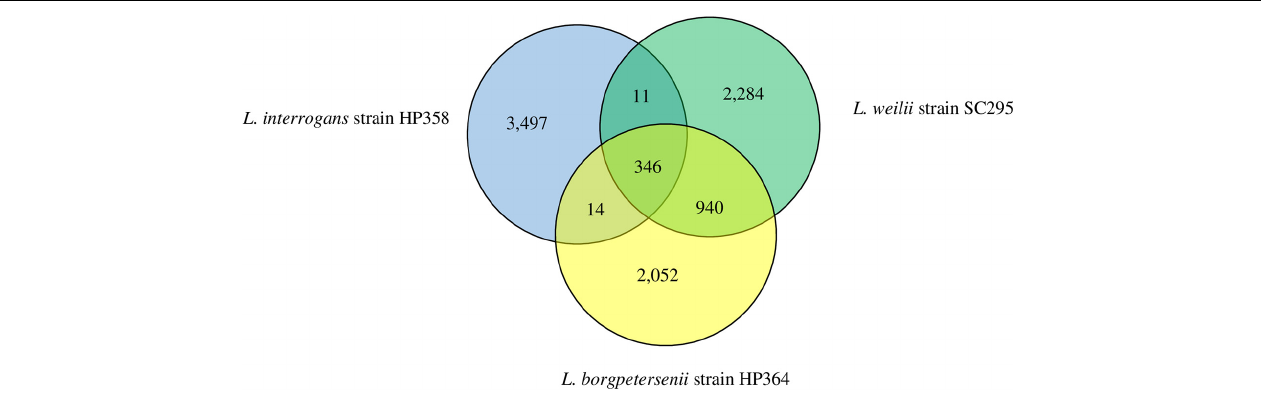
FIGURE 7 | Pan-genome overview. The Venn diagram presents the core genome and the number of genes specific for L. borgpetersenii strain HP364, L. weilii strain SC295, and L. interrogans strain HP358.